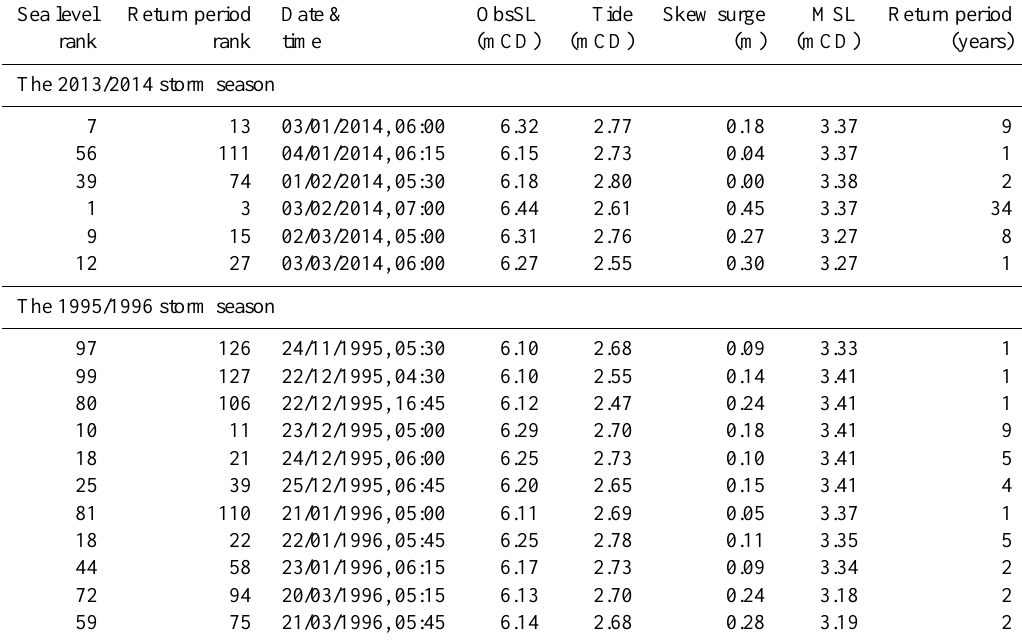
Table 3. Newlyn’s high waters ≥ 1 in 1-year return period during winter 2013/2014, and also the notable 1995/1996 storm season. Sea